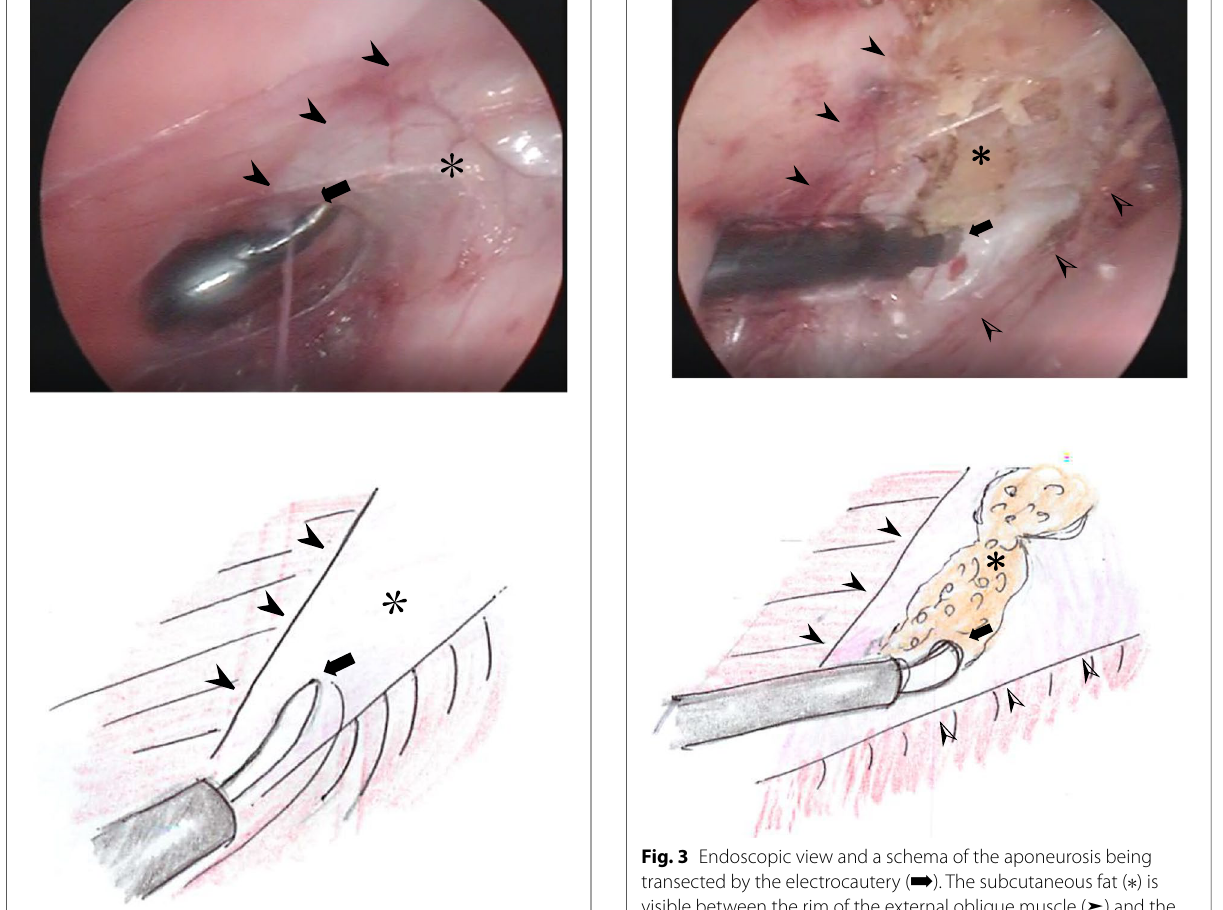
Fig. 2 Endoscopic view and a schema of the space between the external and internal oblique muscles. The aponeurosis ( ∗ ) was identified as the white line, just medial to the external oblique muscle ( ➤ ) and running vertically from the epigastrium to the inguinal ligament. Transection of the aponeurosis was carried by the electrocautery ( ➡ )